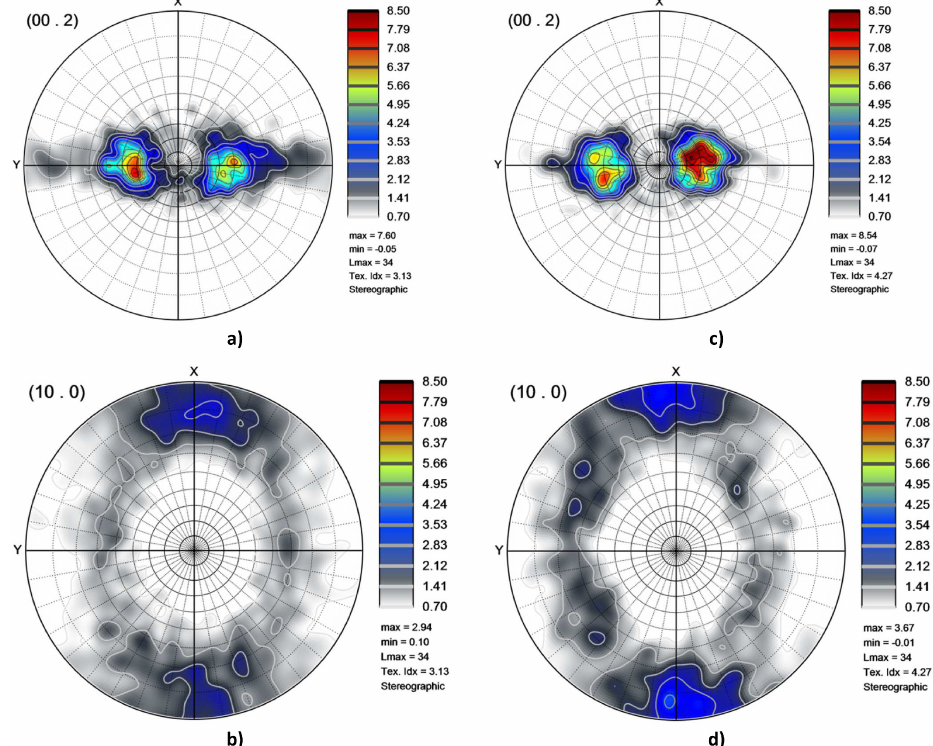
Figure 3. Pole figures for the specimens RR 2.8 ( a , b ) and RR 11.7 ( c , d ) plotted thanks to the ATEX software [25]. x represents the last rolling direction and y the transverse